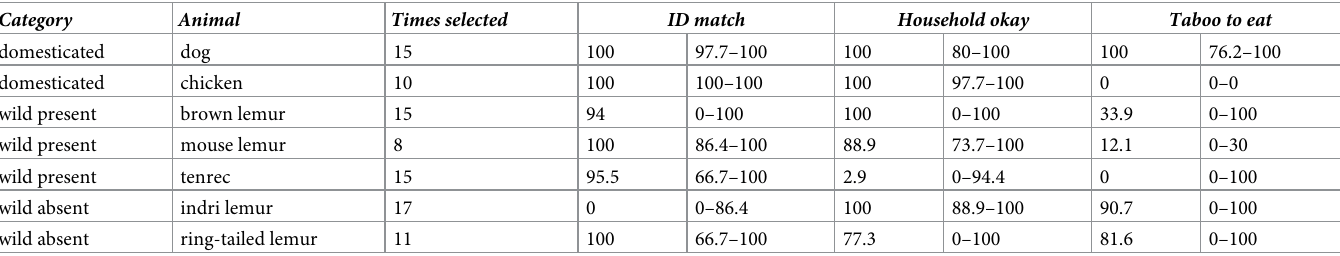
Table 1. List of animals, and responses depicted as medians, minimum and maximum values for animal ID, okay to keep in household, and taboo to